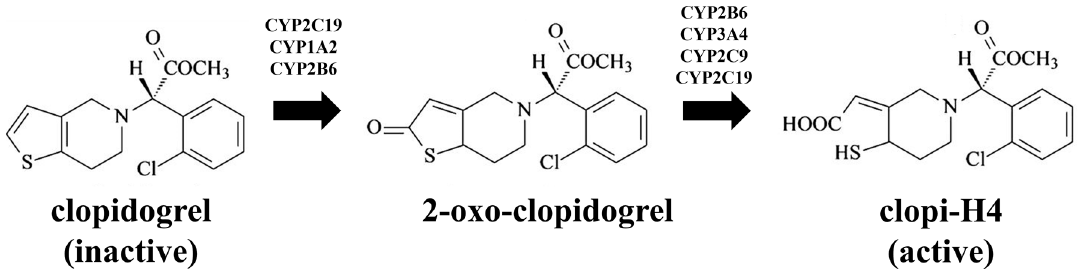
Figure 1. Biotransformation of clopidogrel to the active (H4) metabolite.